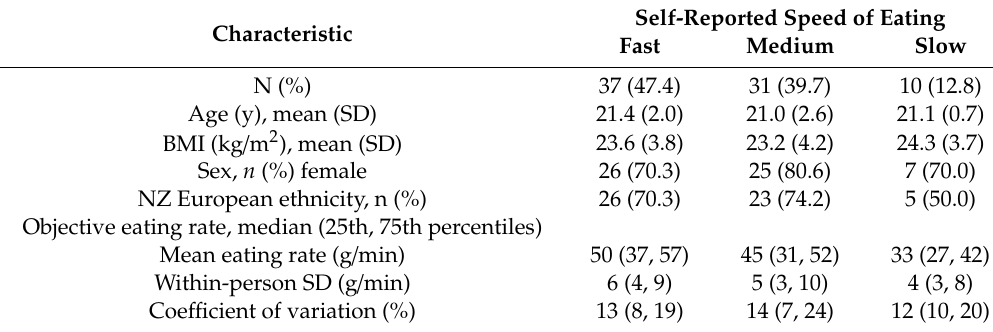
Table 2. Participant demographics and objective eating rates by self-reported speed of eating category ( n = 78). Characteristic